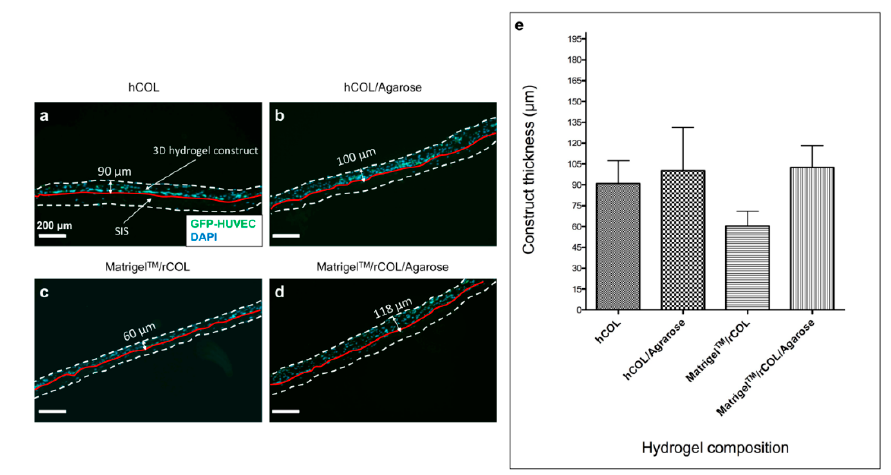
Figure 3. Construct thickness increased slightly in agarose supplemented hCOL and considerably in Matrigel TM / rCOL constructs. ( a – d ) Images of cryo-sections from 3D hydrogel constructs in hCOL ( a ), hCOL / Agarose ( b ), Matrigel TM / rCOL ( c ), Matrigel TM / rCOL / Agarose ( d ). The white dashed lines define the limits of the hydrogel and SIS construct while the red solid line indicates the hydrogel / SIS border. The hydrogel construct is located on the upper side of the red line and contains HUVECs and hASCs visualized with DAPI staining ( a – d ). The up down arrows indicate the average construct thickness for each hydrogel setting with 90 µ m for hCOL ( a ), 100 µ m for hCOL / Agarose ( b ), 60 µ m for Matrigel TM / rCOL ( c ), and 118 µ m for Matrigel TM / rCOL / Agarose ( d ). ( e ) A calculation of construct thickness was done by imaging of three di ff erent cryosections for each hydrogel setting (one construct analyzed per setting). The cross-section of the whole construct was imaged (approximately 9 images per cryosection) and five random thickness measurements were taken per image. Hydrogel thickness is presented as mean ± standard deviation (SD). Scale bar: 200 µ